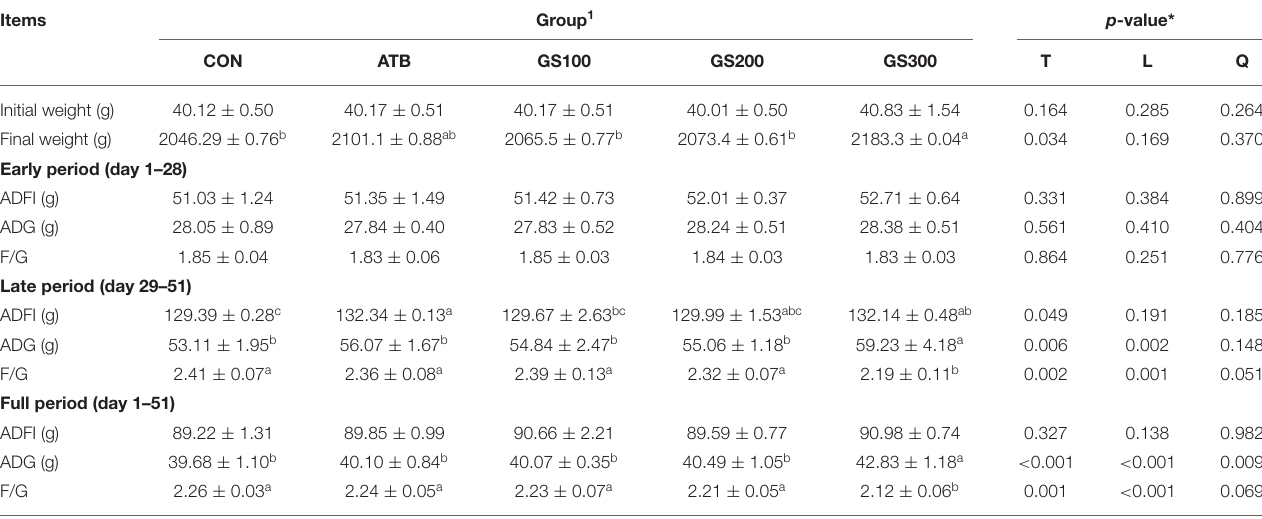
TABLE 3 | Effects of ginsenoside Rg1 on growth performance of broiler chickens ( n =